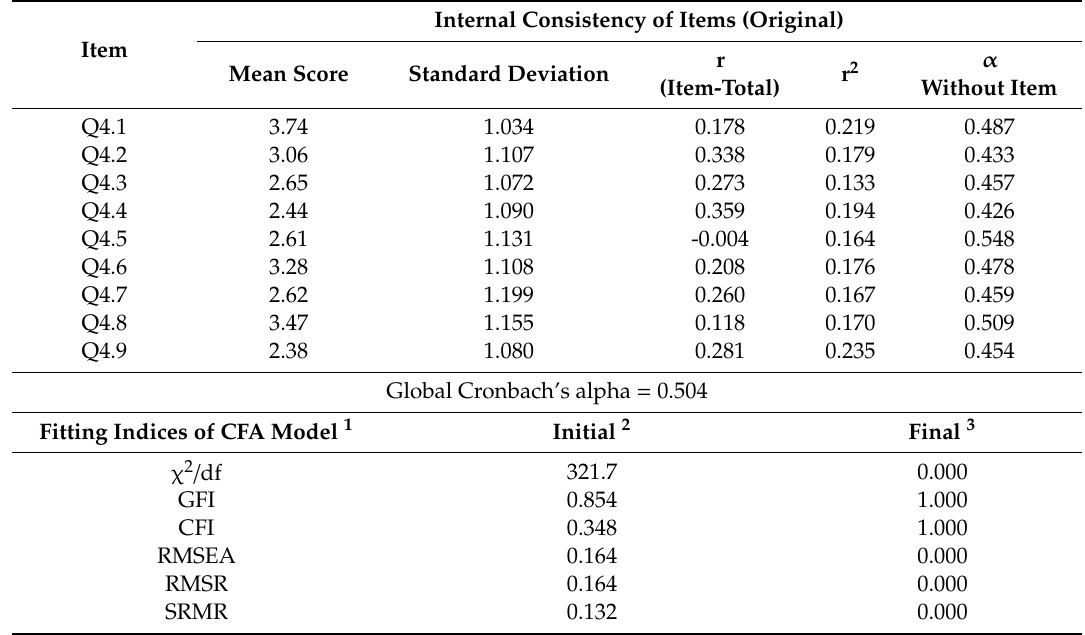
Table 4. Statistics for the unidimensional model of the scale about social and cultural